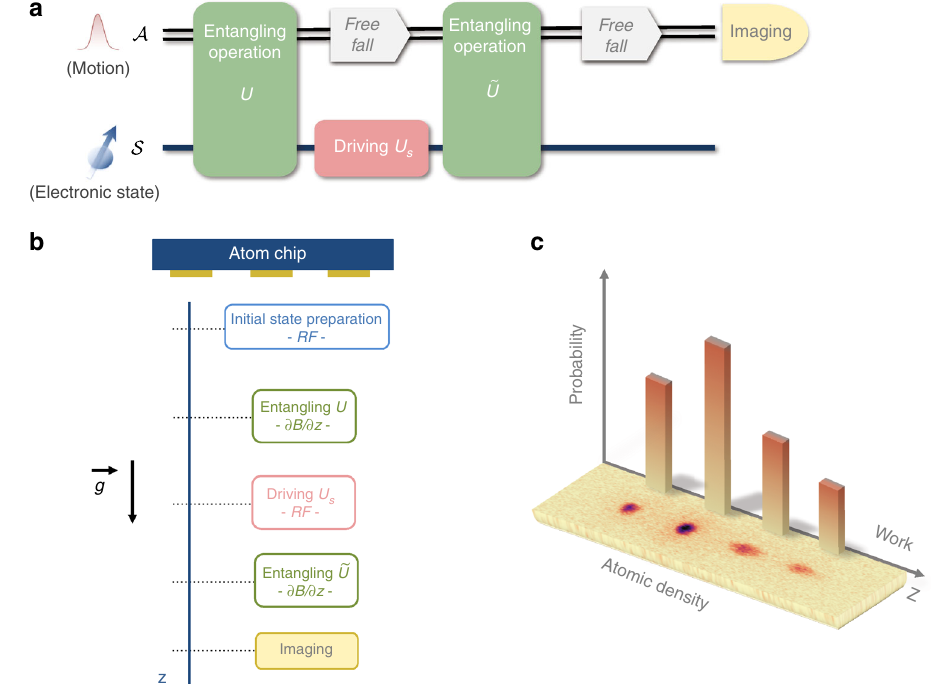
Fig. 1 The quantum work meter. a A quantum circuit for the quantum work meter (QWM). S and A are entangled so that the eigenvalue of the observable H of the system S is coherently recorded by A . Then S is driven by U S . Finally, another entangling operation between S and A creates a record of w on A . In the experiment, A is encoded in the motional degree of freedom of the atoms along the vertical direction z , which also evolves while freely falling. S is the pseudospin associated with the Zeeman sub-levels of a 87 Rb atom. b Physical operations for the QWM on an atom chip: (i) The atoms, prepared in state 2 j i , are released from the trap, and a RF fi eld generates an initial pseudo-thermal state. (ii) After 2.4 ms, internal and motional degrees of freedom are entangled with a magnetic gradient pulse ( U ), applied for a duration of τ = 40 μ s. (iii) Another RF fi eld drives S . (iv) 3.1 ms after the application of U , a second magnetic gradient pulse ( ~ U ) is applied for a duration of ~ τ ¼ 300 μ s. At this stage, A keeps a record of the different work values. (v) After 18.2 ms from the application of ~ U , the positions and optical densities of the atomic clouds are measured. The number of atoms in each cloud reveals the work probability in a single experimental realisation. c Image of the four clouds obtained at the end of a single run of the QWM. The four possible values of w fi x the position of each